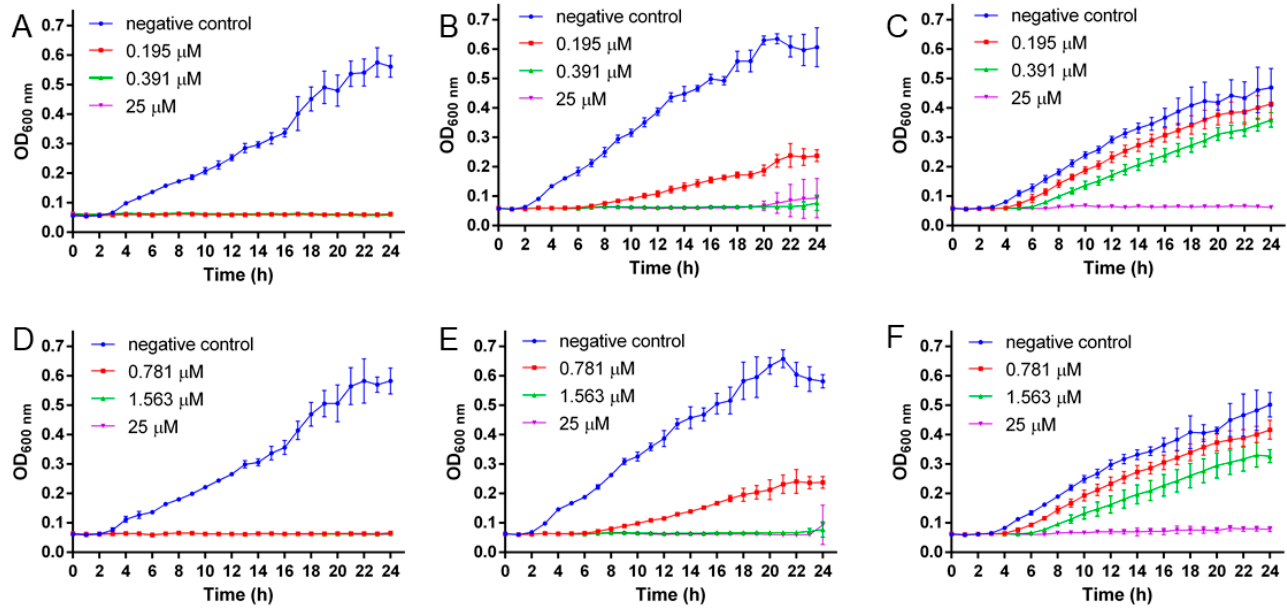
Figure 2. Tests of bacterial kinetic growth curves of FA and FA-15 for the three Gram-positive strains: Staphylococcus aureus (ATCC 6538; A , D ), Staphylococcus albu (ATCC 29213; B , E ), and Staphylococcus epidermidis (ATCC 12228; C , F ) exposed to three different compound concentrations of FA ( A – C ) and FA-15 ( D – F ); n = 4.